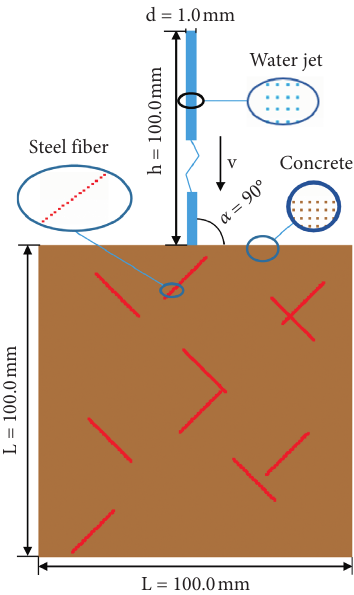
Figure 1: Geometric model of UHP-WJ impacting